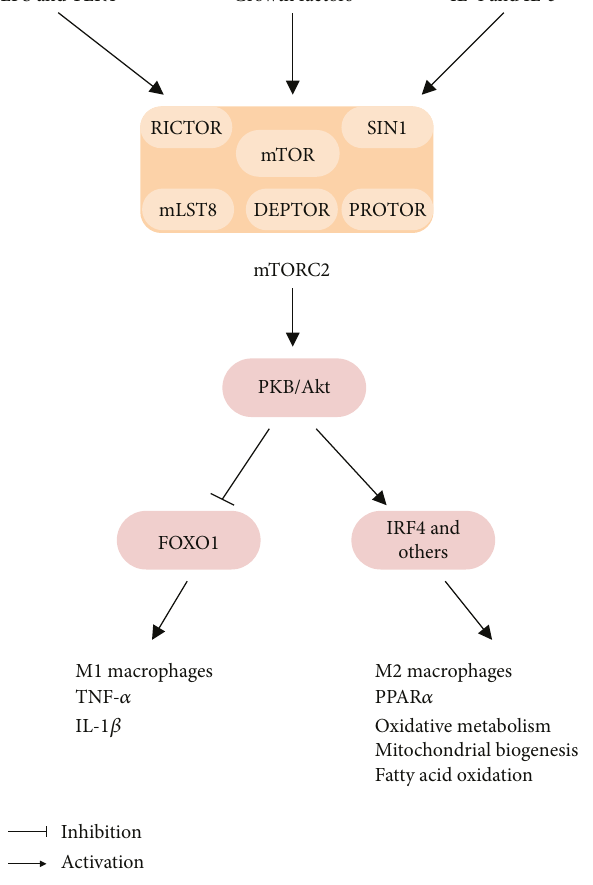
Figure 4: mTORC2 is activated in both M1 and M2 polarization and regulates important metabolic processes at both conditions.